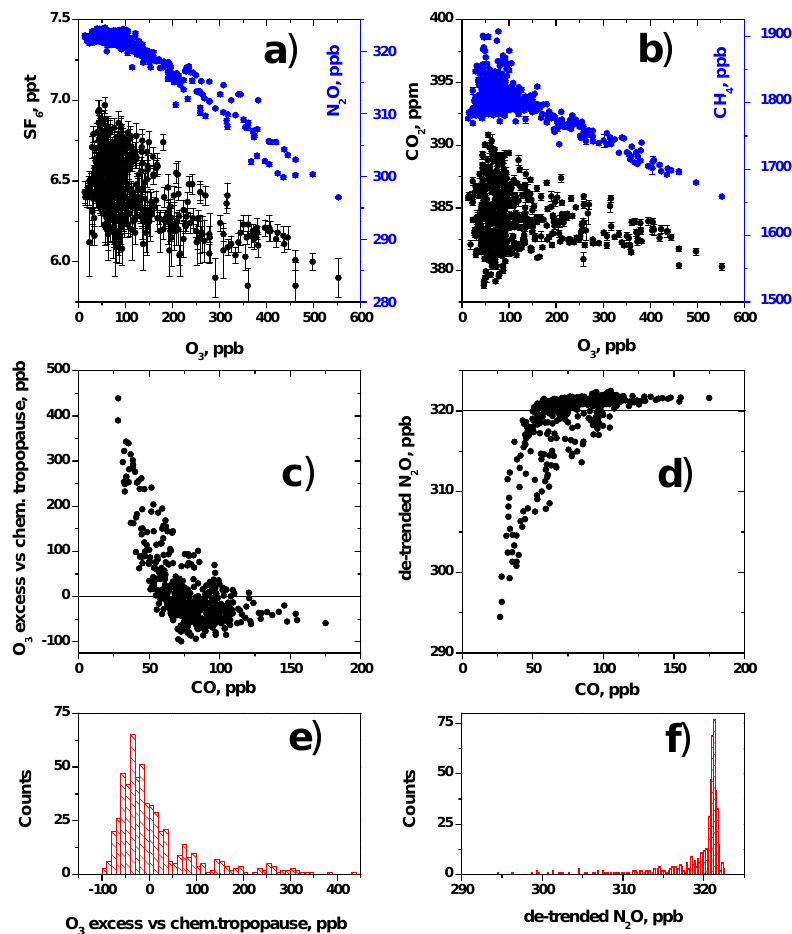
Fig. 2. (a–b) GHG data (N 2 O, SF 6 , CH 4 and CO 2 ) for CARIBIC-2 flights from April 2007 to March 2009 (period covered by CO 2 isotope analyses) plotted against ozone. The data are not de-trended and all samples (tropical free troposphere, UT and LMS) are all plotted together. (c–d) Comparison of stratospheric tracers O 3 and N 2 O. De-trended N 2 O data vs. CO demonstrate a more compact distribution for tropospheric air masses (N 2 O above 320ppb) than the distribution of O 3 vs. CO. (Tropospheric air may be distinguished as having O 3 excess vs the chemical tropopause above zero). (e-f) histograms of O 3 and N 2 O